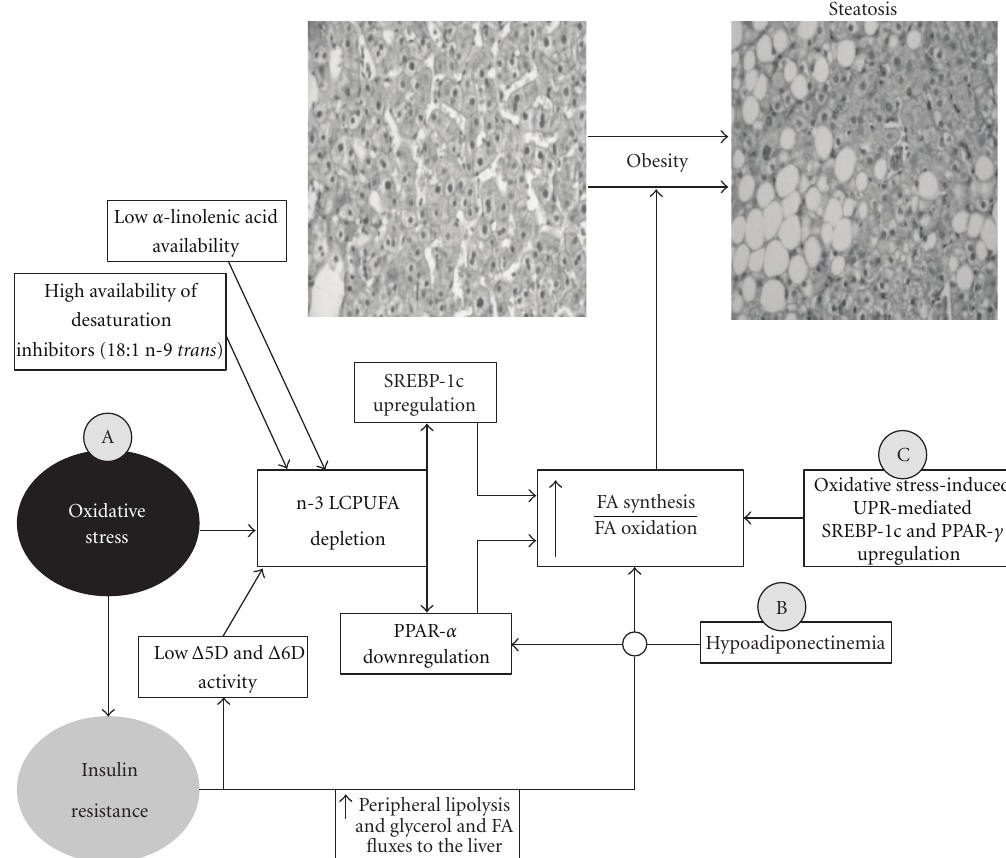
Figure 1: Obesity-induced liver oxidative stress (A), hypoadiponectinemia (B), and endoplasmic reticulum stress (C) as factors leading to hepatic steatosis in nonalcoholic fatty liver disease. Abbreviations: Δ 5(6)D: delta-5(6) desaturase; FA, fatty acid; LCPUFA: long-chain polyunsaturated fatty acid; PPAR- α ( γ ): peroxisome proliferator-activated receptor- α ( γ ); SREBP-1c: sterol regulatory element binding protein-1c; UPR: unfolded protein